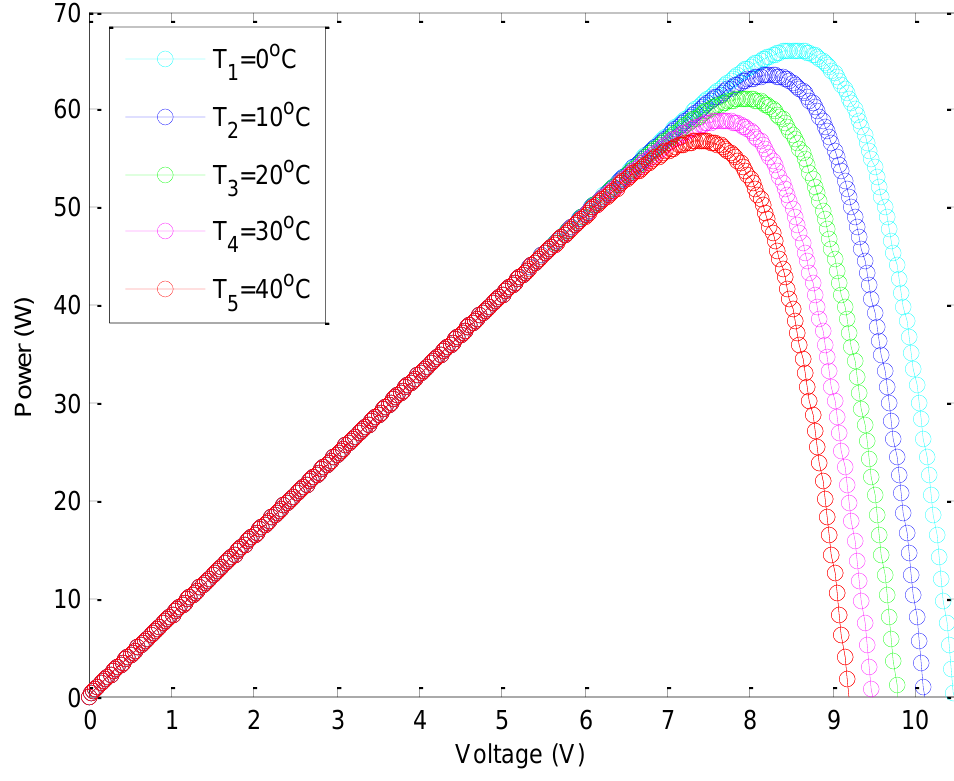
Figure 11. Power-voltage characteristic curves of photovoltaic cells for various temperature and constant